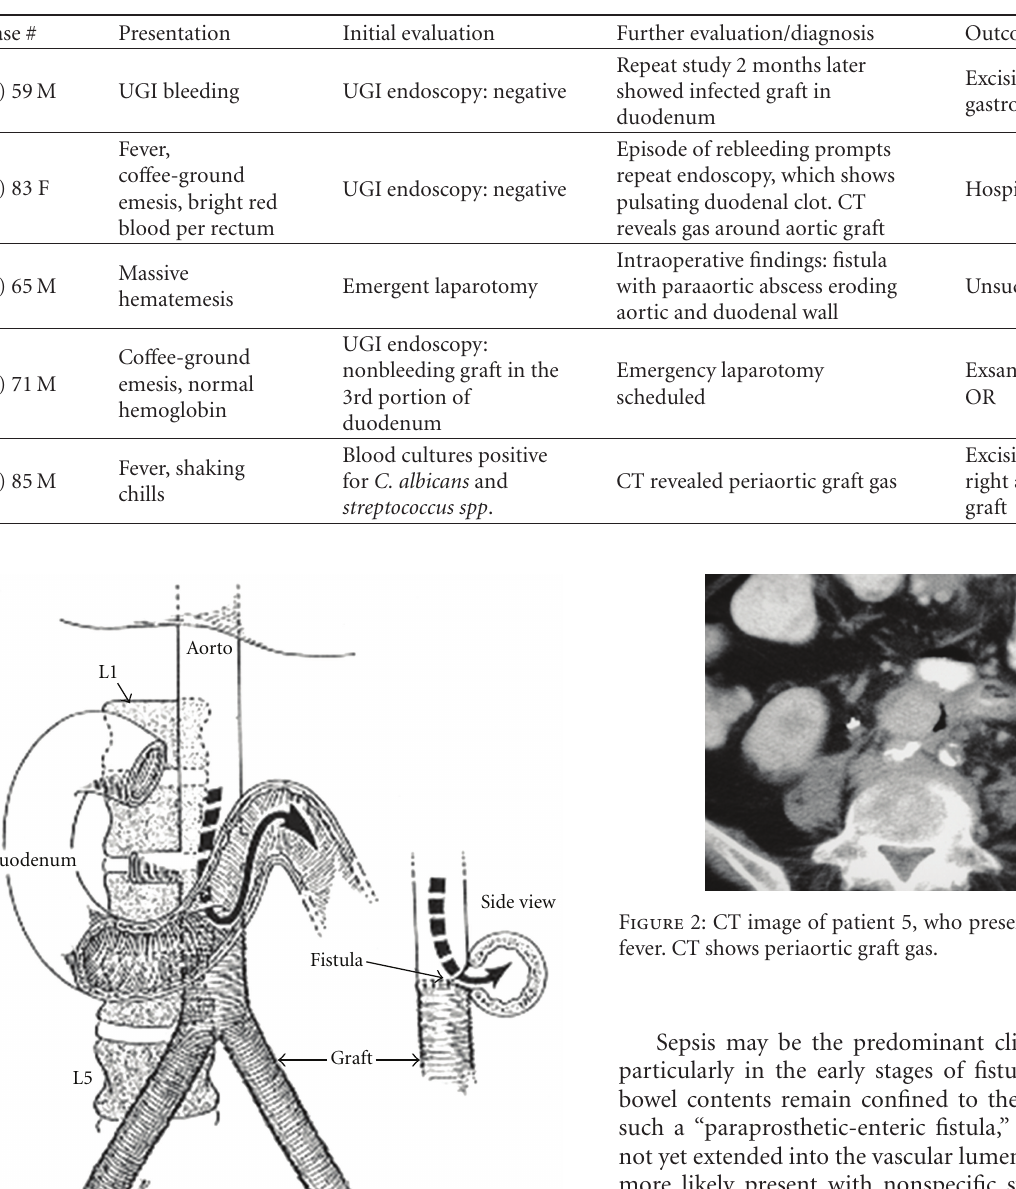
Table 1: Presentation and outcomes of aortoenteric fistulae.